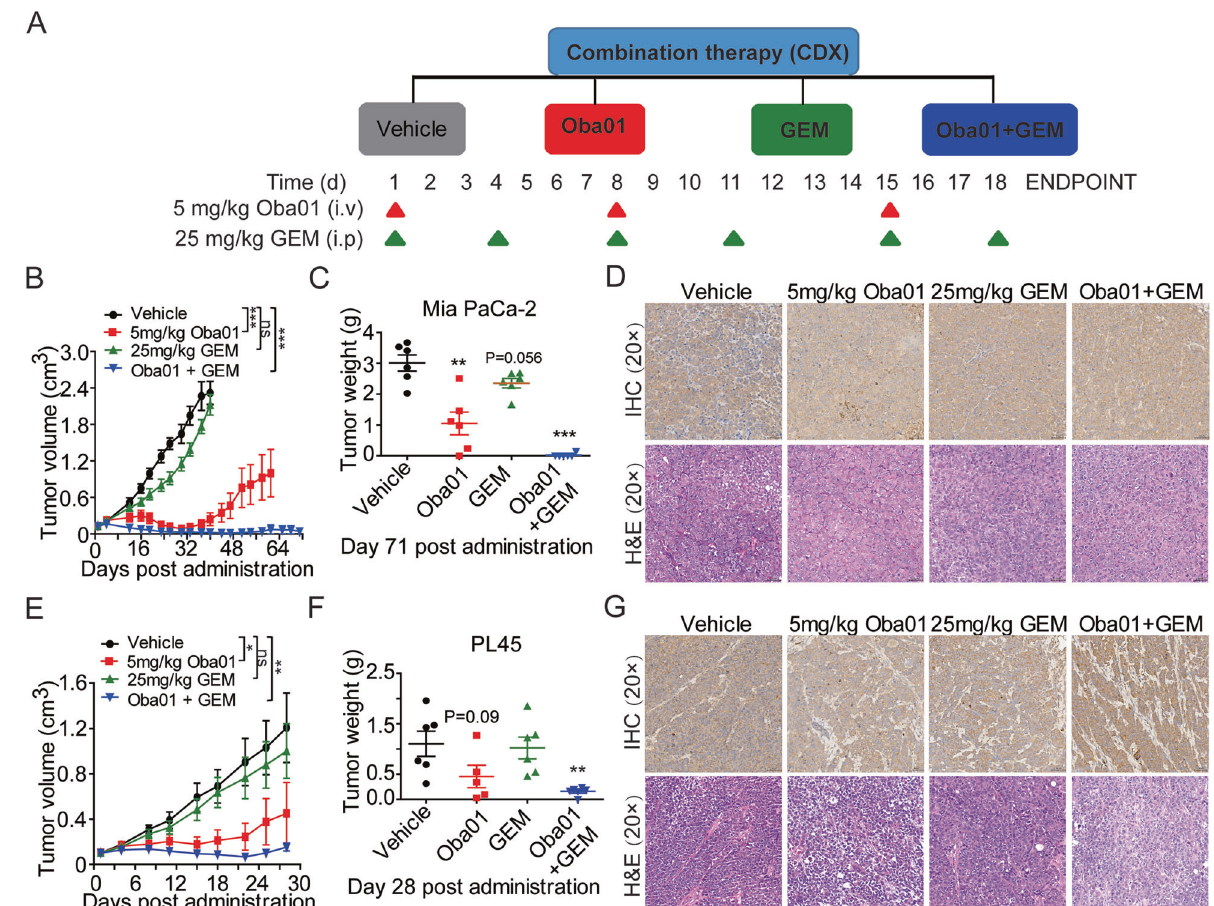
Fig. 6 Combination of Oba01 and gemcitabine signi fi cantly inhibited pancreatic cancer tumor growth in Mia PaCa-2 and PL45 CDXs. A Schematic representation of the experimental designs. Treatment groups, doses, and schedules are shown. Oba01 (red line; 5 mg/kg) and vehicle (black line) injections were administered intravenously and gemcitabine (GEM, green line) was administered intraperitoneally; the combination group is depicted as a blue line. B , C Tumor growth curve and the transplanted tumor weight was evaluated in the Mia PaCa-2 CDX model. D IHC analysis of the DR5 expression (upper panels) and H&E staining (lower panels) in the Mia PaCa-2-transplanted CDX tumors. E , F Tumor growth curve and transplanted tumor weight was evaluated in the PL45 CDX model. G IHC analysis of DR5 expression (upper panels) and H&E staining (lower panels) in the PL45-transplanted CDX tumors. IHC and H&E Images were captured at 200× magni fi cation, respectively. Scale bars = 50